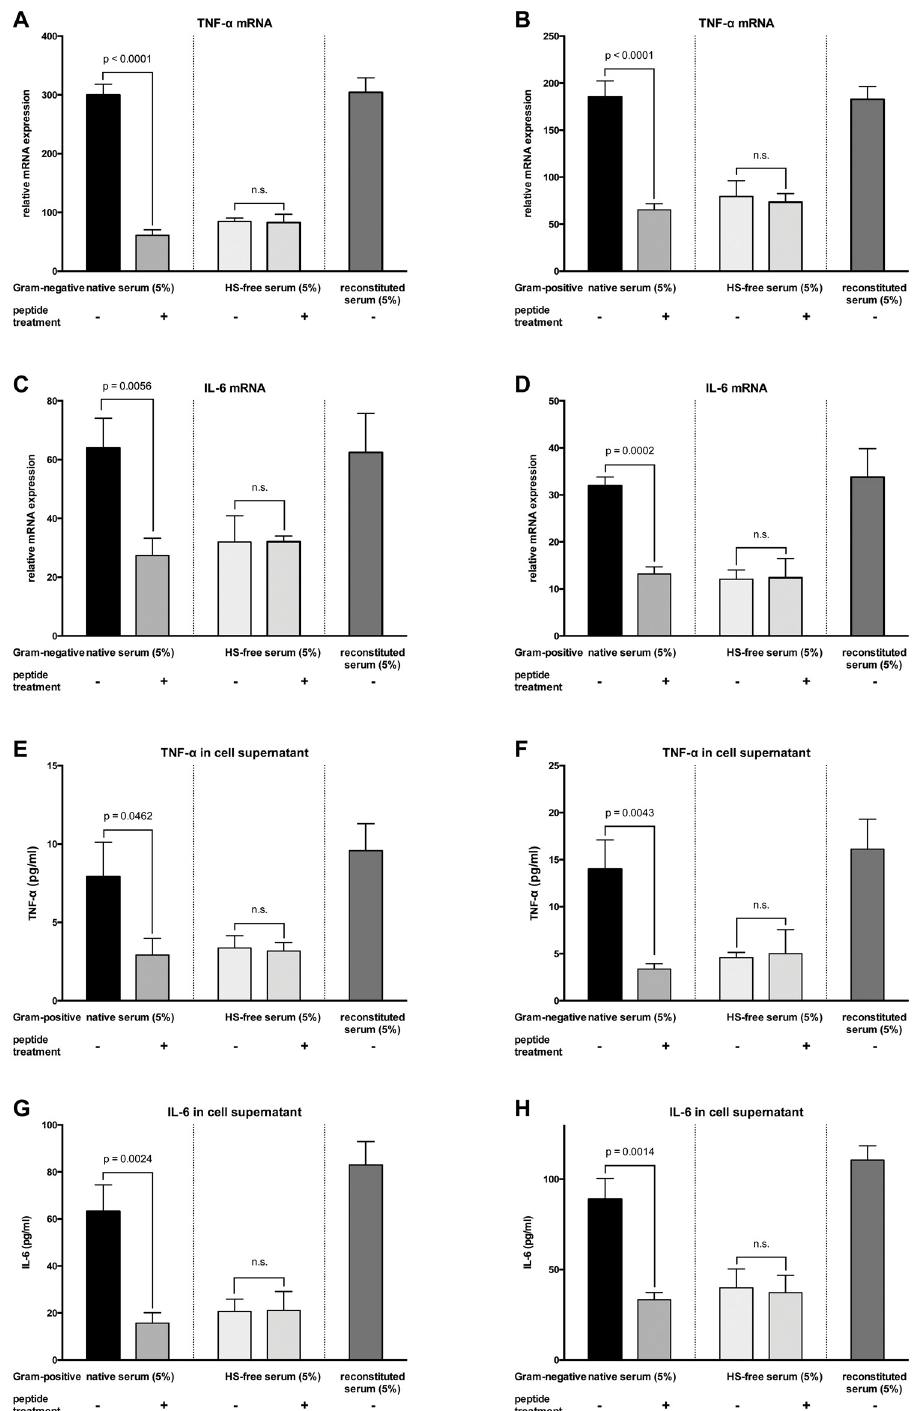
Fig 5. TNF- α and IL-6 mRNA expressions and secreted protein concentrations of HL-1 cells stimulated with sera from patients with septic shock. HL-1 cells were stimulated as described in Fig 4 and induction of mRNAs encoding the pro-inflammatory cytokines TNF- α (A and B) and IL-6 (C and D) were measured. (E and H) Secreted protein concentrations of TNF- α and IL-6 were determined in supernatants using ELISA. Fig 5 shows the data for stimulation with 5% serum, other concentrations see Tables 2 and 3. Data represent the mean ± SD of triplicate samples, representative of three independent experiments.